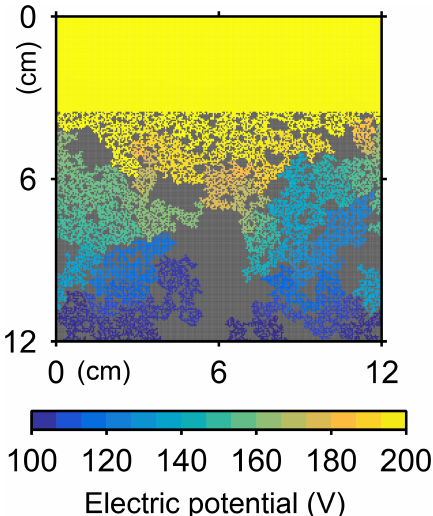
Figure C3. Electric potentials for formation factor calculation at the beginning of simulation (a) in Sect.